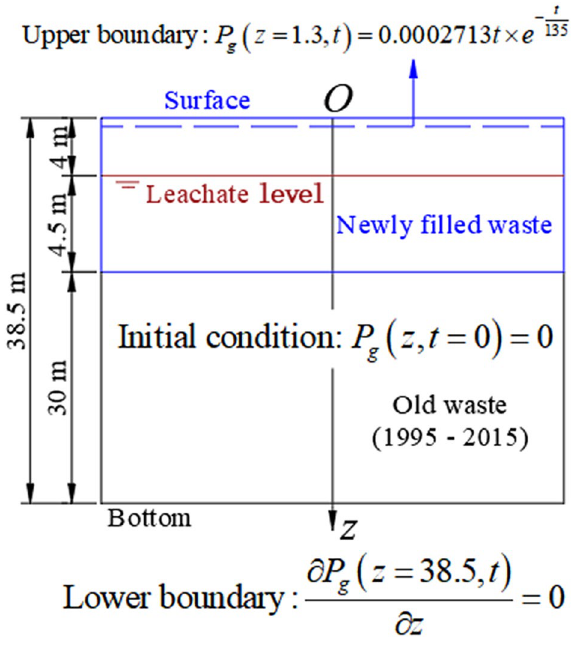
Figure 3. Physical model for gas transport in the Wuxi